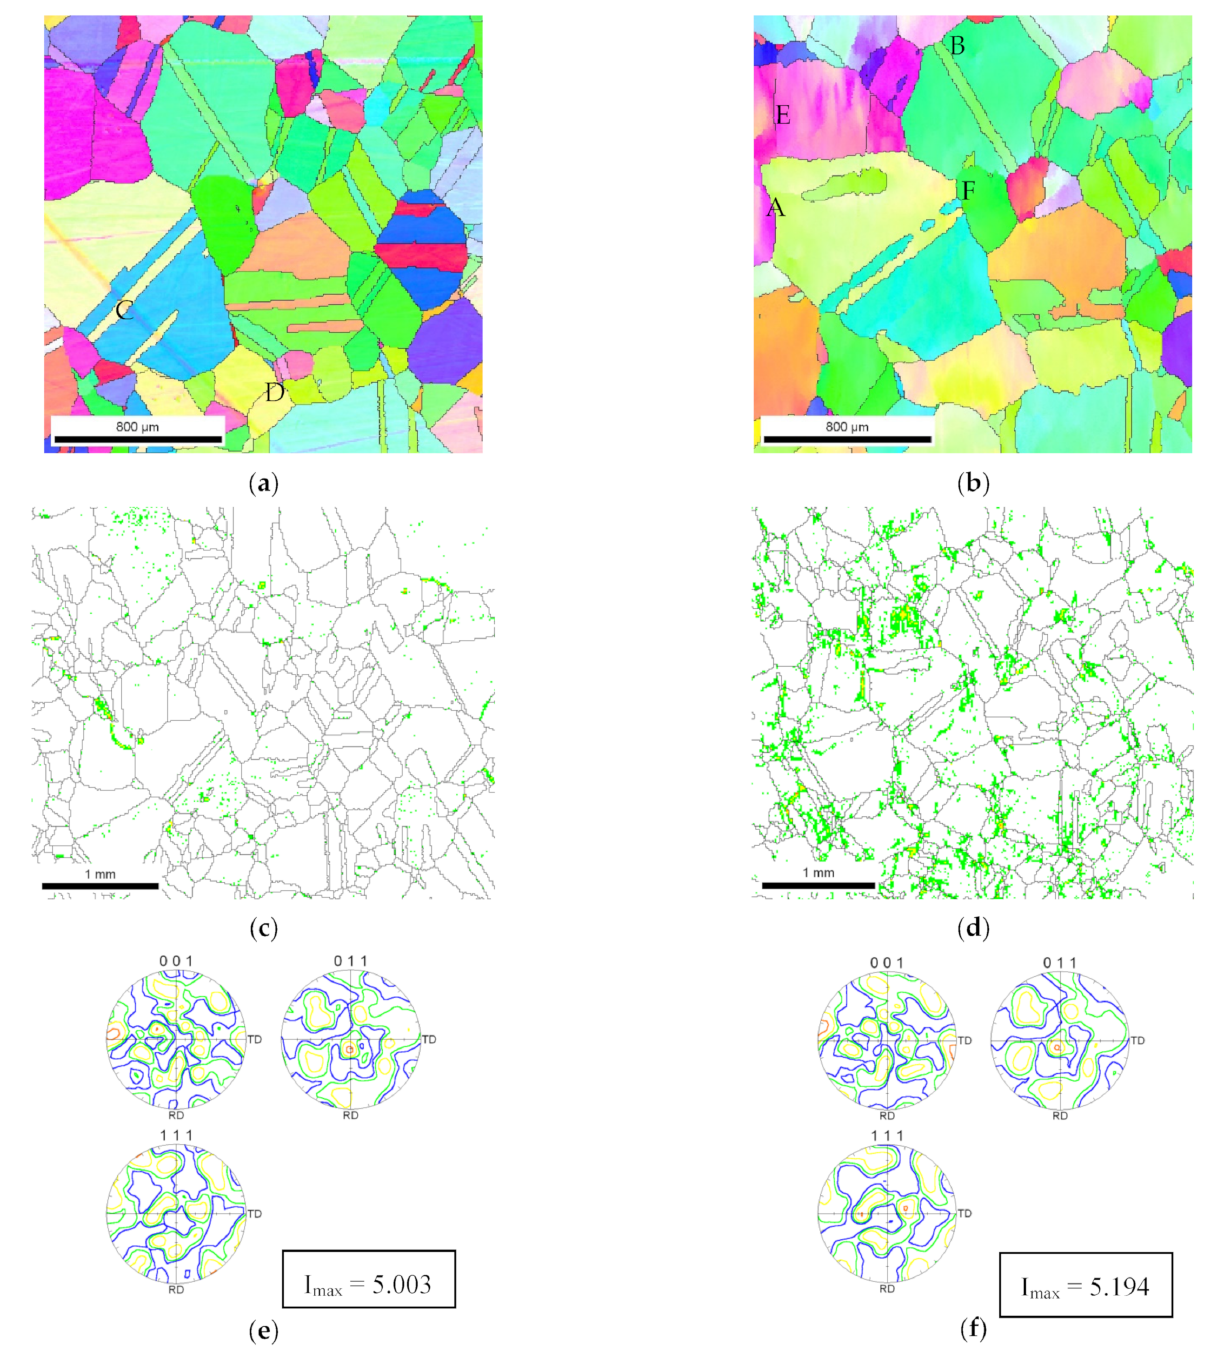
Figure 7. The IPF maps ( a , b ), KAM-maps ( c , d ) and pole figures of coarse-grained nickel: ( a , c , e )—before ultrasound treatment; and ( b , d , f )—after ultrasound treatment with an oscillating stress amplitude of 20 MPa